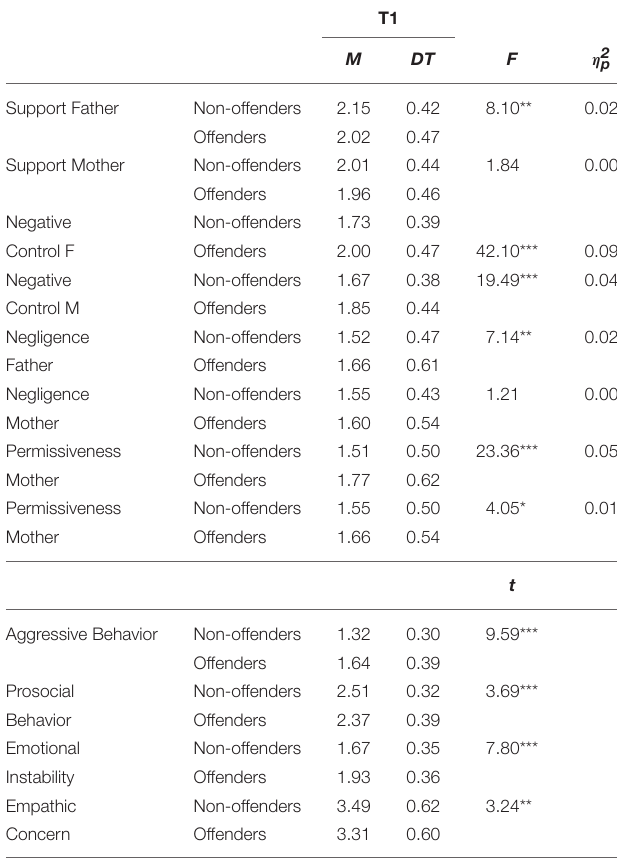
TABLE 2 | MANOVAs, Means, standard deviations, MANOVA, and student’s t -tests for non-offender and offender